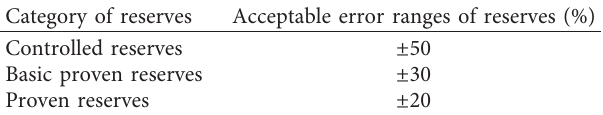
Table 1: Acceptable error ranges for various reserve